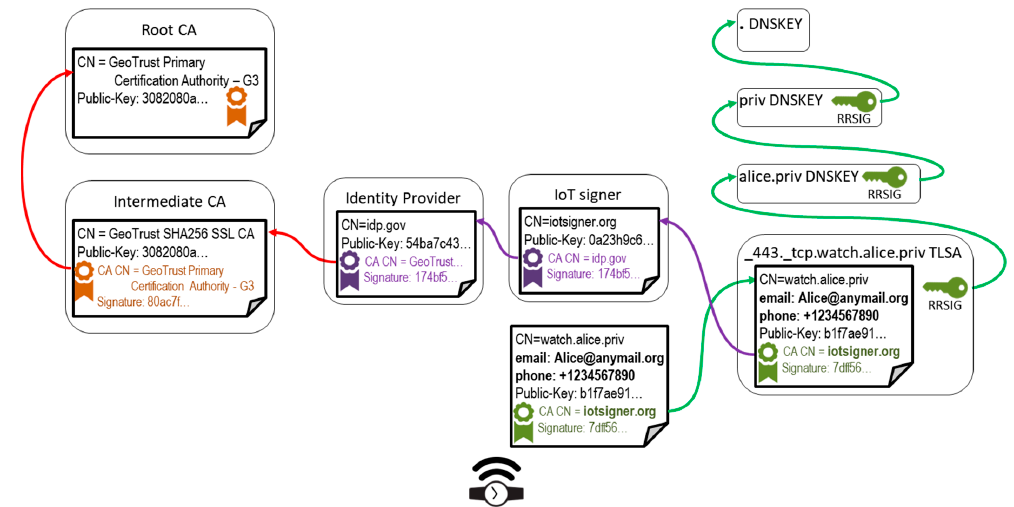
Figure 2. Introduction of identity provider and Internet of Things (IoT) signer services leads to reinforcement of device owner identification and to device certificate generation outsourcing, respectively. Unlike in Figure 1, the device certificate gets signed by the IoT signer, which in turn is authorized to use identity provider services to identify the device owner.